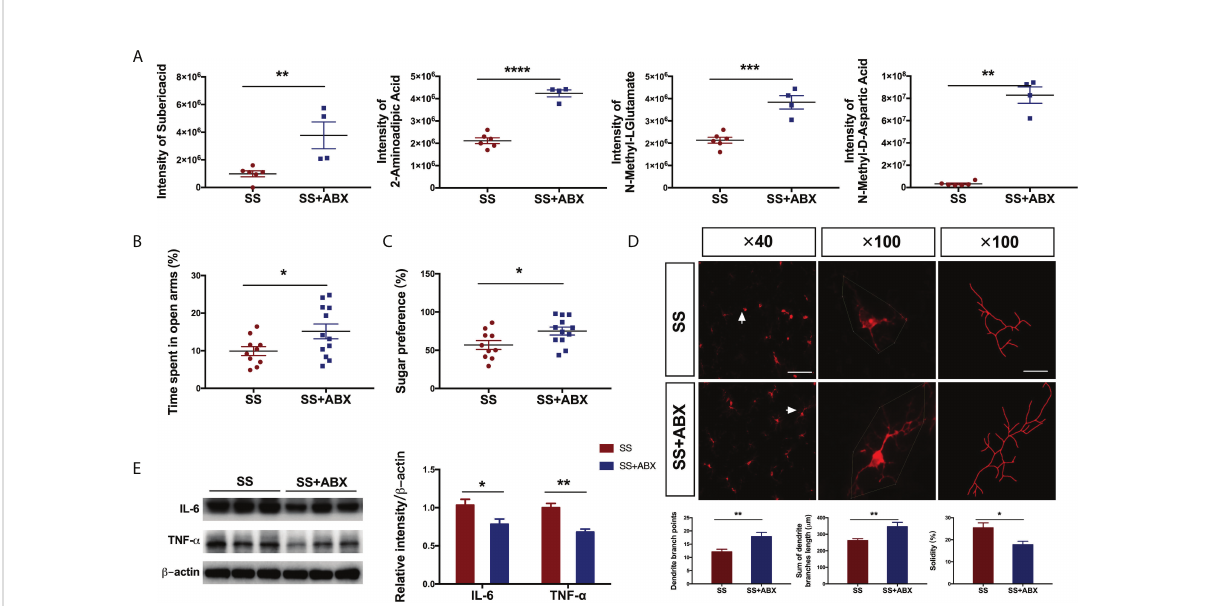
FIGURE 6 Antibiotics attenuated the anesthesia/surgery induced changes in rats with preoperative stress (A) Relative abundances of suberic acid, 2- aminoadipic acid, N-methyl-L-glutamate, and N-methyl-D-aspartic acid in fecal samples of SS and SS+ABX group (n = 4-6/group). (B) Time spent in the open arm of SS and SS+ABX group (n = 12/group). (C) Sugar preference in SPT of SS and SS+ABX group (n = 12/group). (D) Immuno fl uorescence staining and morphological analysis of microglia in the hippocampus of SS and SS+ABX group (n = 16/group). Arrows denote the area represented in the inset. Scale bar = 50 µm; 20 µm for inset. (E) Representative blot and quantitative analysis of IL-6 and TNF- a in the hippocampus of SS and SS+ABX group (n = 6/group). An unpaired t-test was used for normally distributed data and the Mann-Whitney U test was used for non-normally distributed data. Data represent mean ± SEM. *P<0.05, **P<0.01, ***P<0.001, ****P<0.0001 vs SS group. SS, preoperative and anesthesia/surgery stress; SS+ABX, SS and antibiotics pretreatment before anesthesia/surgery